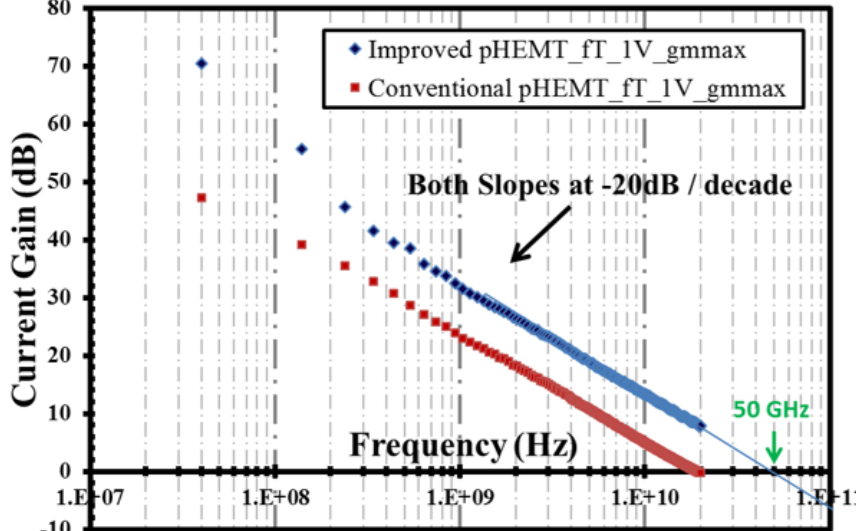
Figure 13. Unity current gain or cut-off frequency (f T ) at g mmax for V DS = 1 V